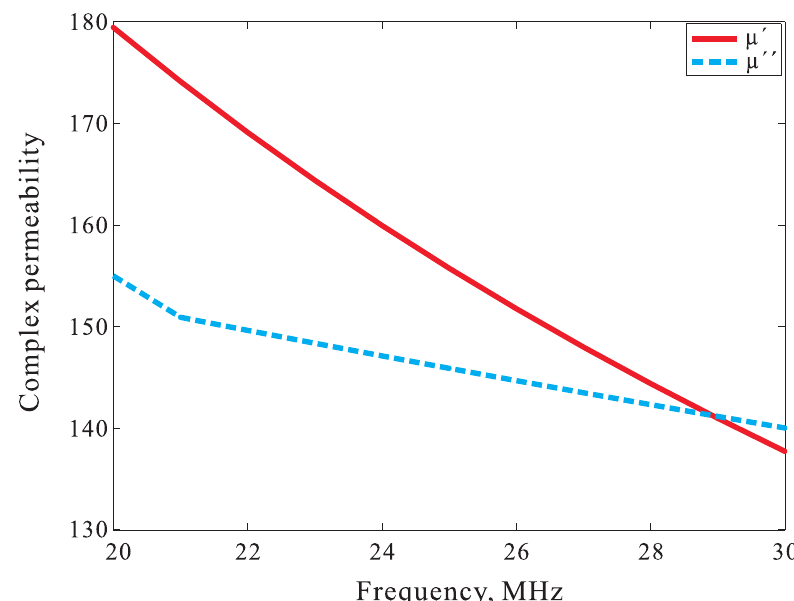
Figure 1. Complex permeability of the MP2106-0M0 ferrite.